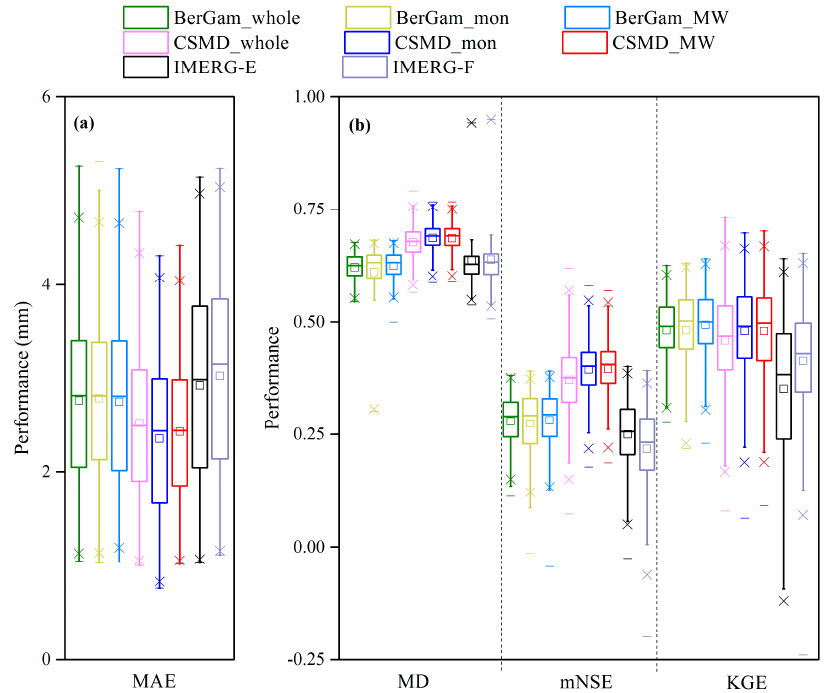
Figure 8. Summary of four metrics in space over Yangtze River basin. ( a ) MAE , in which lower values indicate better performance; and ( b ) MD , mNSE , and KGE , in which higher values indicate better performance. BerGam and CSMD are the traditional and improved bias correction of distribution mapping respectively, while whole, mon, and MW denote three different time-window selection schemes, as discussed in Section 3.2, used to sample precipitation data for one routine. Thus BerGam–whole denotes the traditional BerGam approach implemented using the whole period time-window scheme. Similarly, the other five short names represent the combination of a specific approach and time window